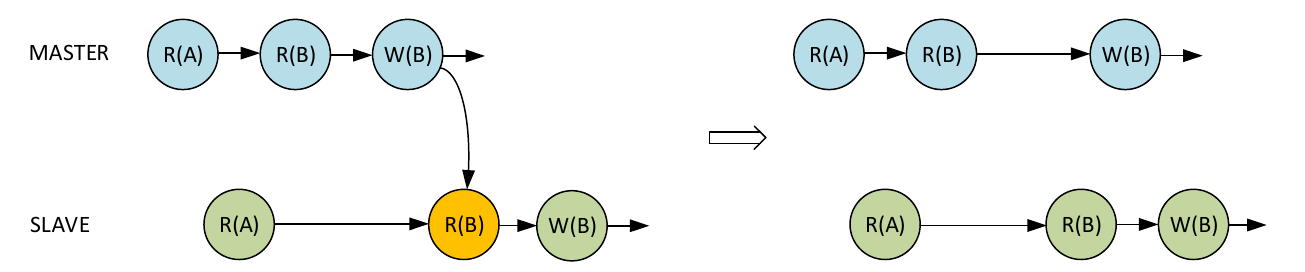
Figure 6. Slave attempt to read data after master updated main memory.